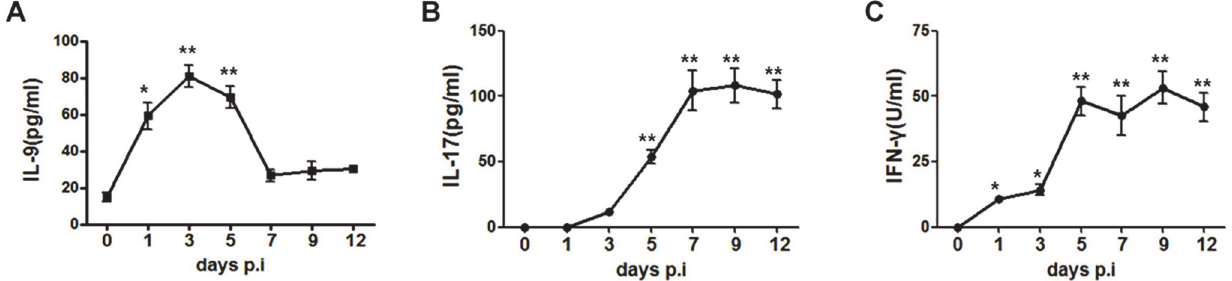
Fig 1. Kinetics of local IL-9, IL-17 and IFN- γ production following lung Cm infection. C57BL/6 Mice were inoculated intranasally with Cm (1×10 3 IFUs) and were sacrificed at the indicated days. The lungs were isolated and the lung homogenates was prepared to detect IL-9(A), IL-17(B) and IFN γ (C) protein levels by ELISA. One representative experiment of two independent experiments (4 mice in each group) is shown. The results are shown as mean ± SD. The levels of IL-9, IL-17 and IFN- γ at various days post-infection were compared to those on day 0 by ANOVA ( * p < 0.05; ** p < 0.01).